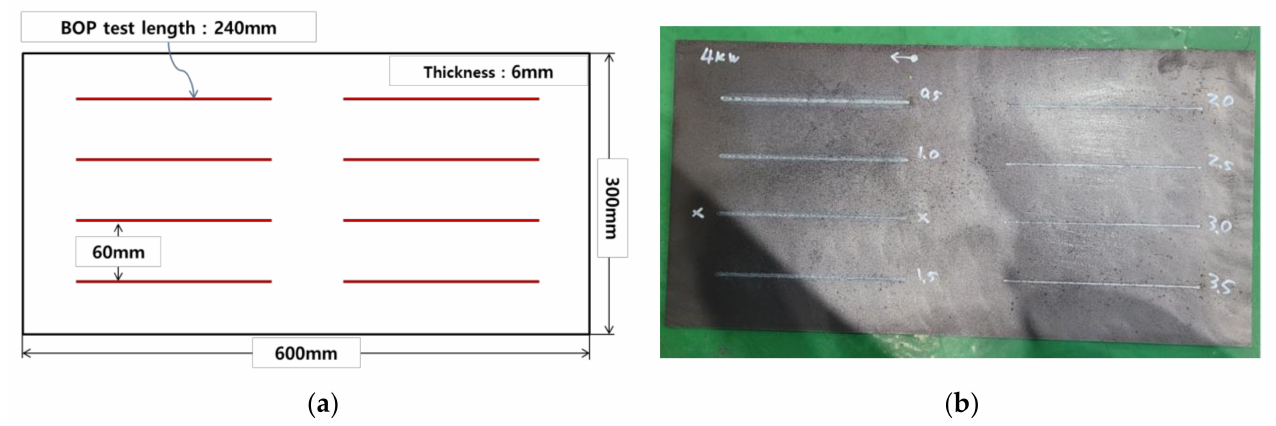
Figure 1. ( a ) BOP welding location on a specimen ( b ) Actual test